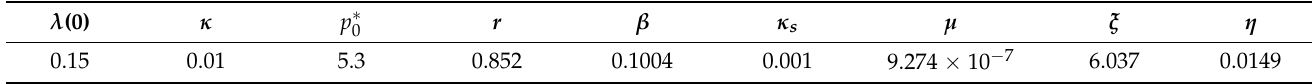
Table 2. Parameters for GMZ